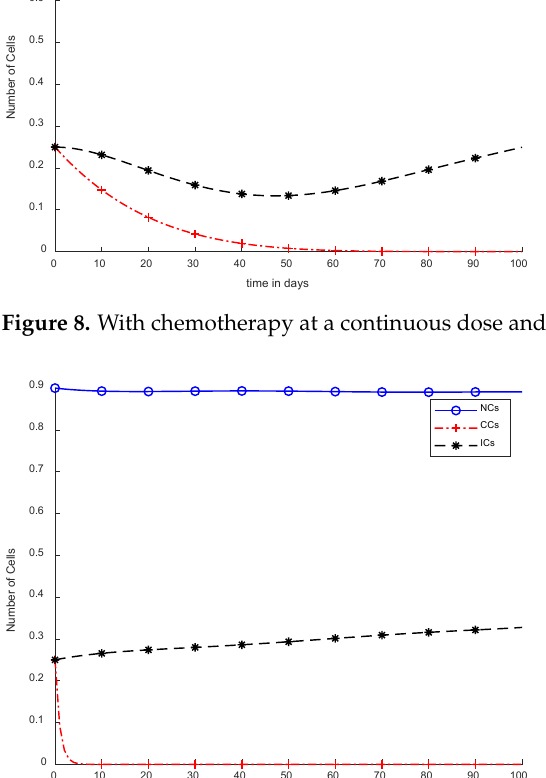
Figure 9. With chemotherapy at a constant dose and SC to kill CCs.